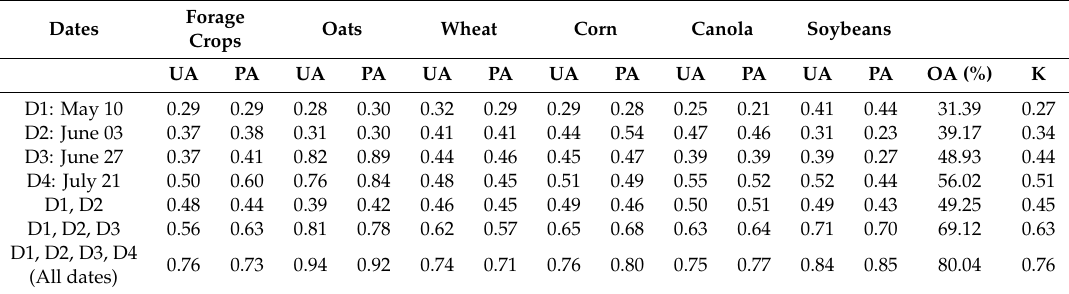
Table 4. Classification results obtained from intensity features of FP SAR data (see S4 in Table 3), using pixel-based RF classifications.